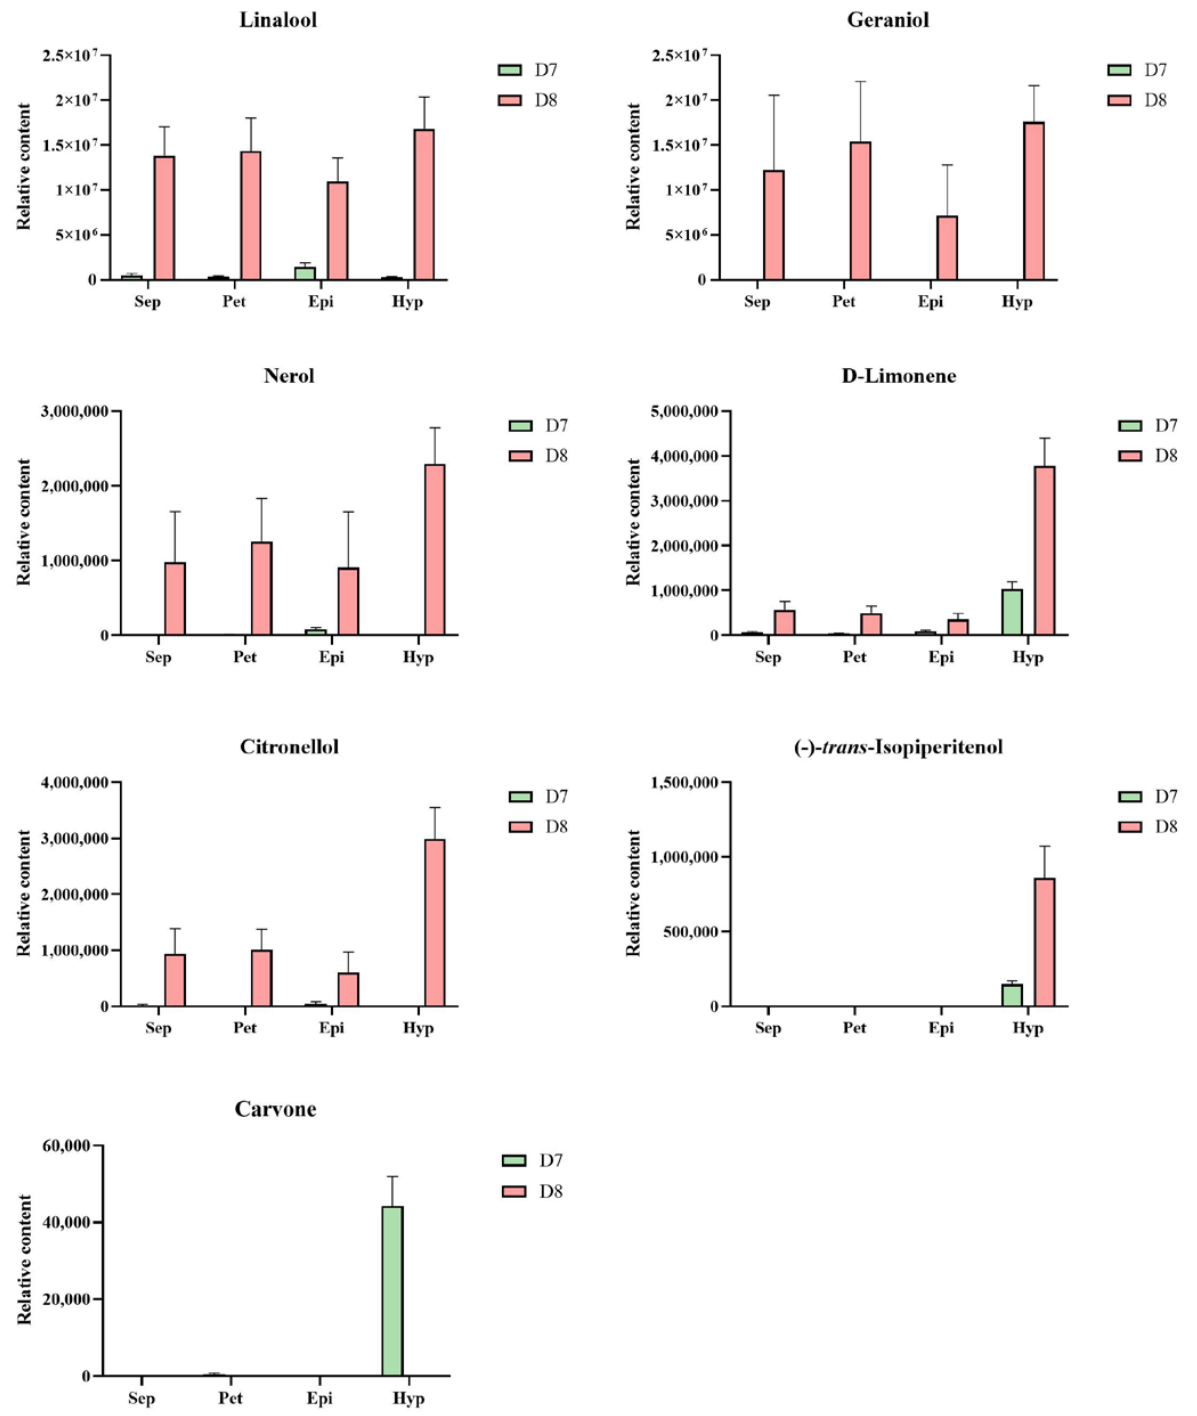
Figure 4. Spatiotemporal accumulation of monoterpenes in KOVA flowers at different developmental stages. The relative contents of each monoterpene in the flower parts at D7 and D8. The relative content represents the result calculated by the external standard method based on data produced by GC. The data are the mean ± SD from three biological